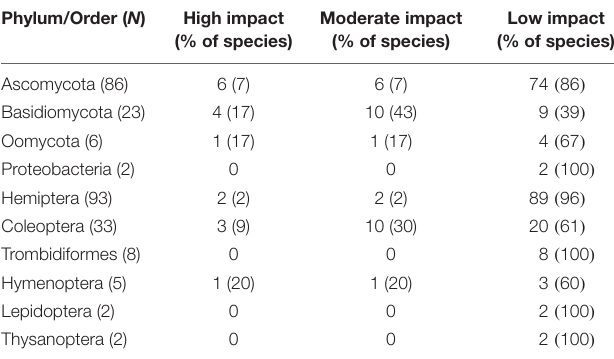
TABLE 1 | Number (and %) of non-native forest pest species by Phylum (for pathogens) and Order (for arthropods) according to impact level in Australia. Phylum/Order ( N ) High impact Moderate impact Low impact (% of species) (% of species) (% of